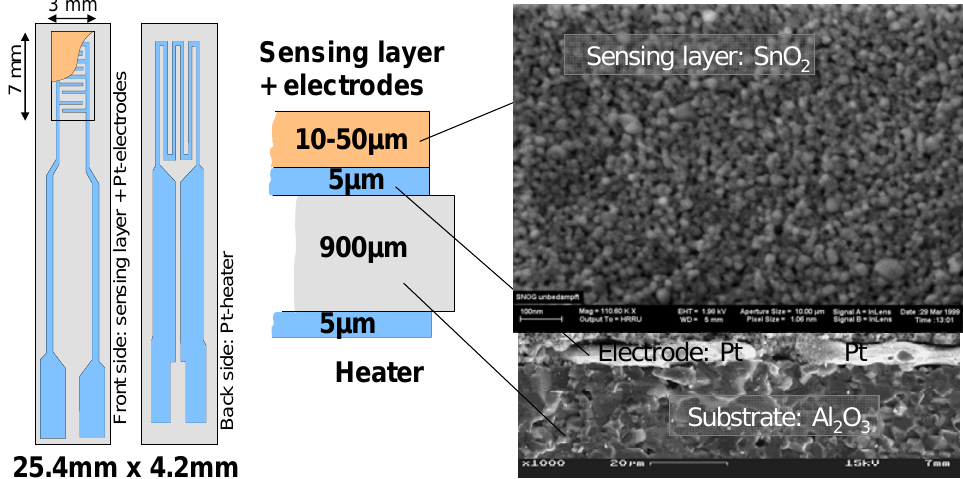
Figure 7. Typical samples used in the operando